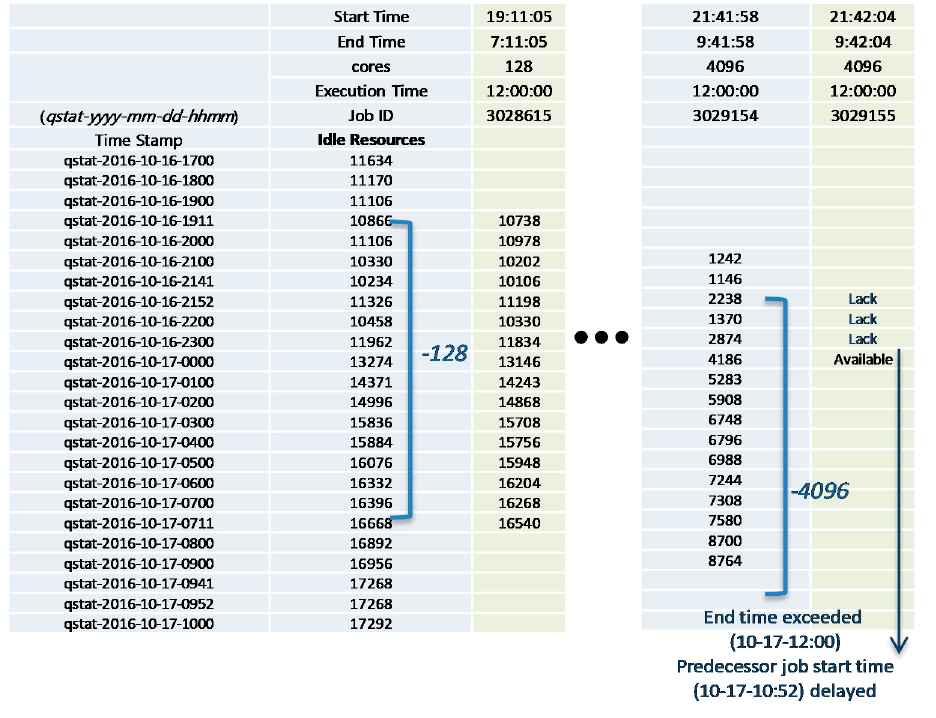
Figure A1. Selecting backfill jobs and updating job profiles.